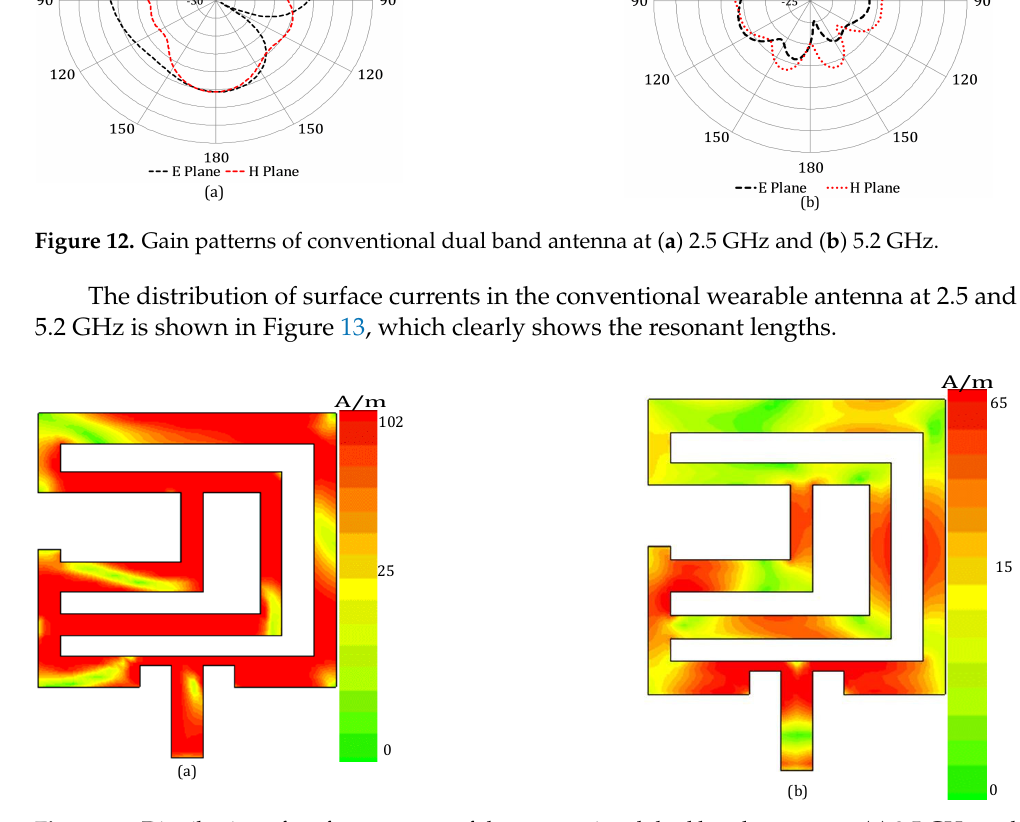
Figure 13. Distribution of surface currents of the conventional dual band antenna at ( a ) 2.5 GHz and ( b ) 5.2 GHz.